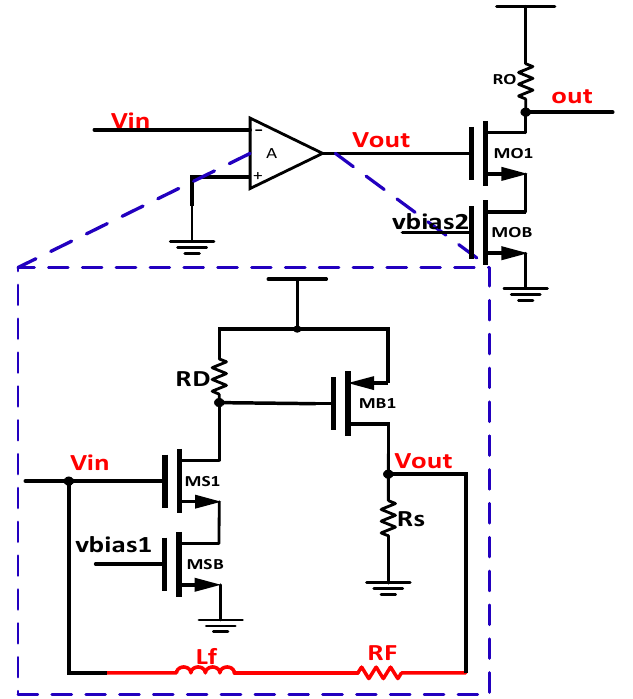
Figure 7. Schematic of Single-ended TIA.